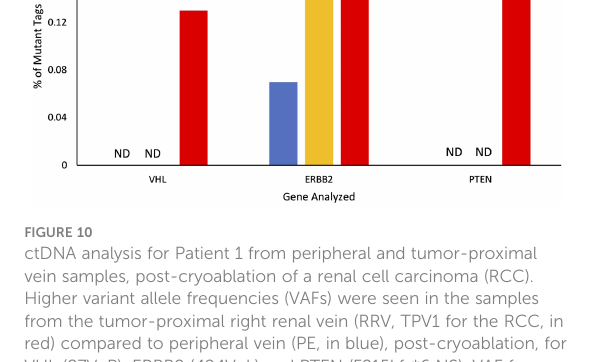
TPV4 sample (70.9 copies/ml) compared to a peripheral specimen